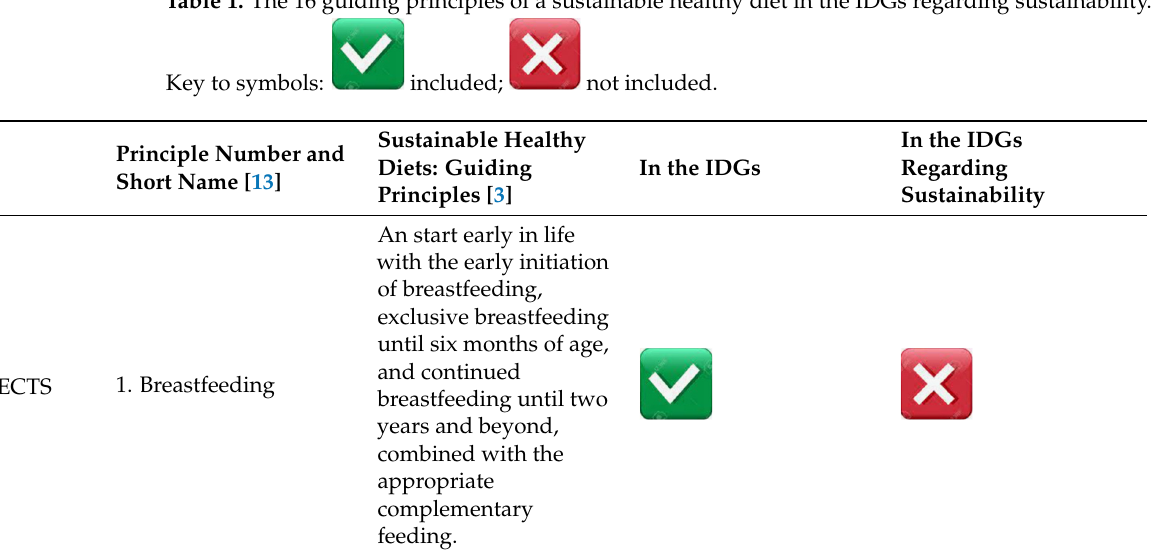
Table 1. The 16 guiding principles of a sustainable healthy diet in the IDGs regarding sustainability. Key to symbols: